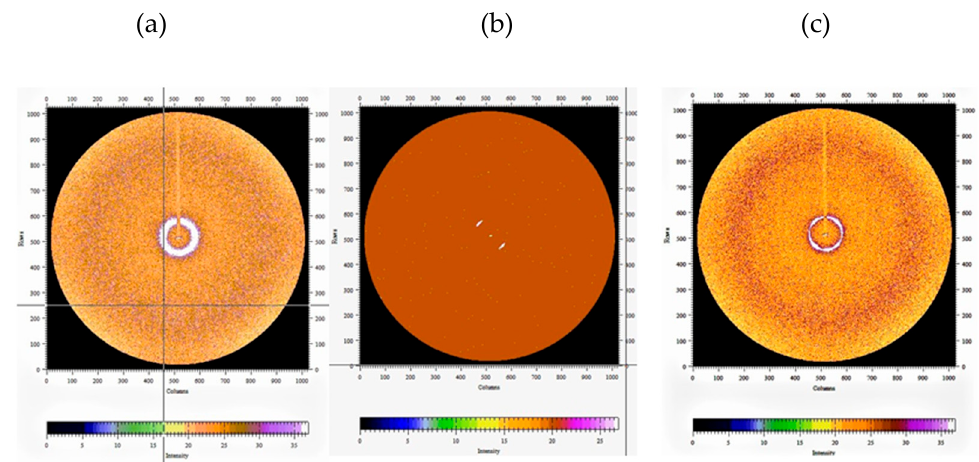
Figure 5. The X-ray di ff raction patterns of EV8. ( a ) Isotropic phase taken at 200 ◦ C; ( b ) Sharp inner arcs of SmA taken at 190 ◦ C; ( c ) SmA of inner ring sharp and outer ring di ff use at 180 ◦ C.